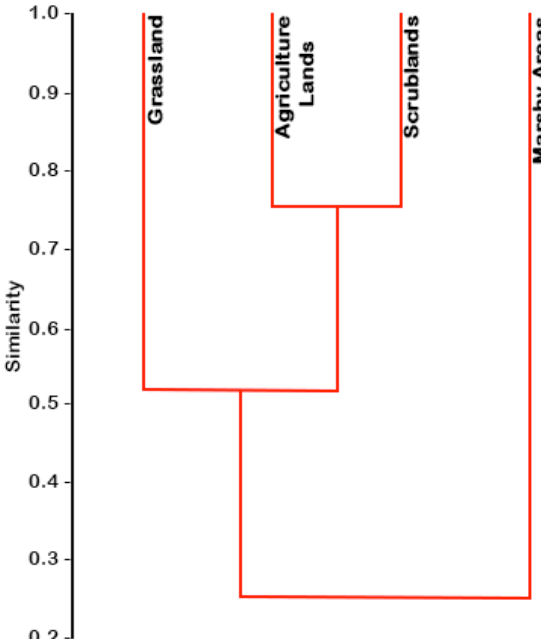
Figure 2. Similarity between habitats with respect to species richness at Manjeera Wildlife Sanctuary, Medak District,